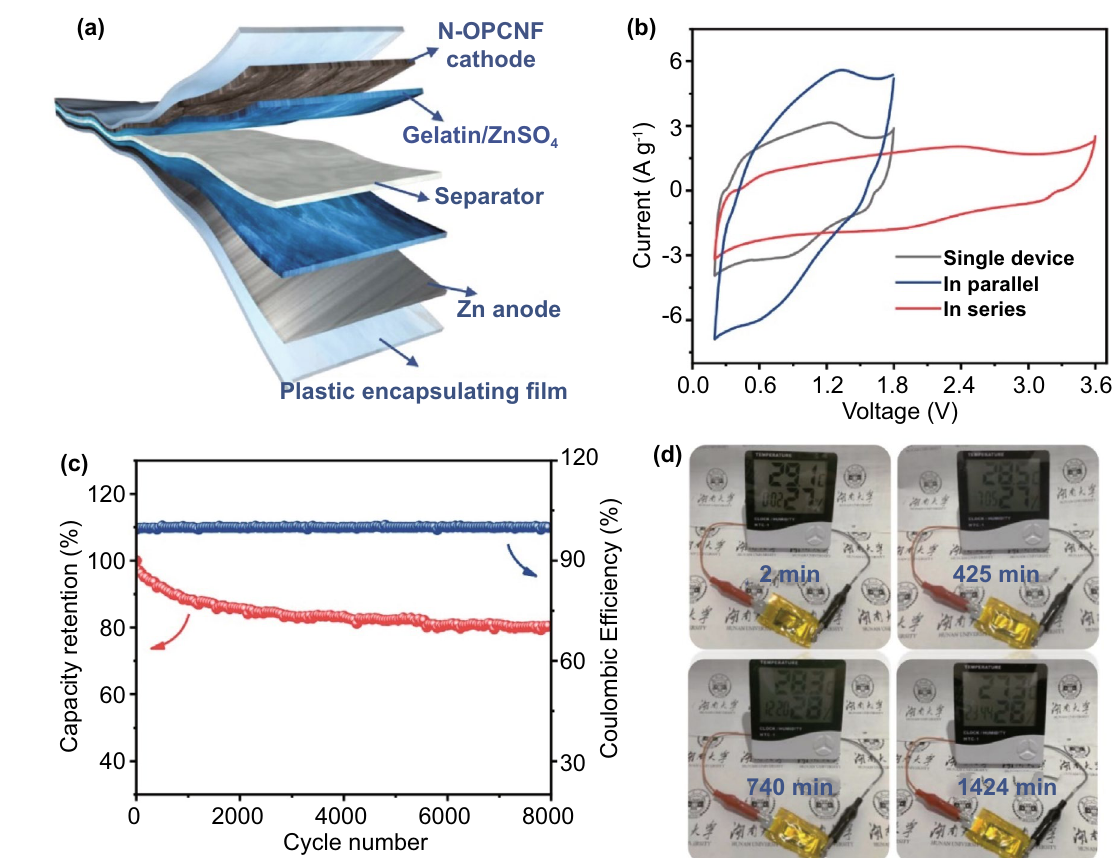
Fig. 5 a Schematic diagram of the as-assembled quasi-solid-state ZIHC. b CV profiles of single device, two devices in parallel and in series at 10 mV s −1 . c Capacitance retention and Coulombic efficiency of the quasi-solid-state ZIHC at 1 A g −1 for 8000 cycles. d Photograph records of a quasi-solid-state ZIHC powered timer at different discharge